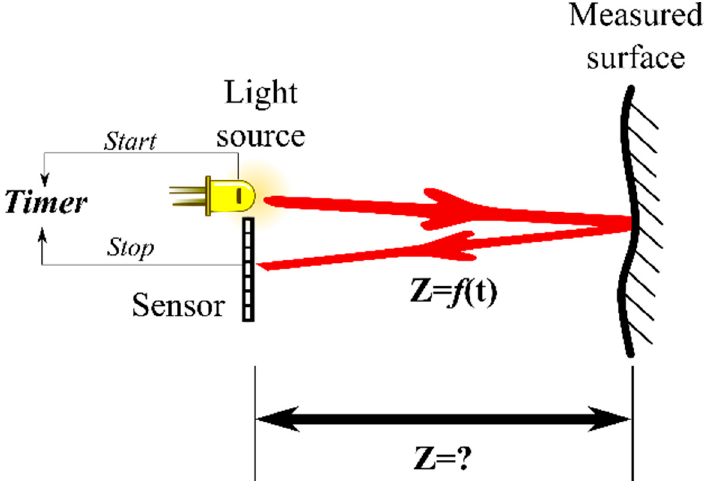
Figure 3. Schematic representation of the basic principle of time-of-flight measurement, where